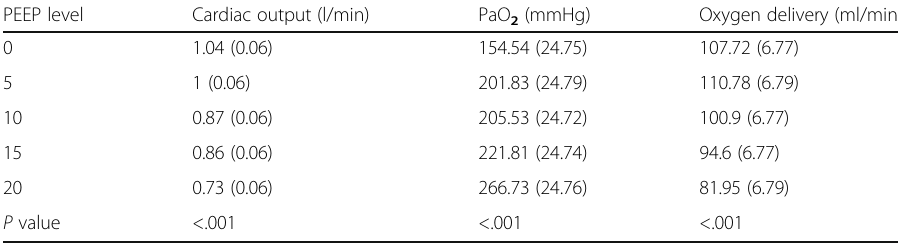
Table 2 Primary outcomes: mean CO, PaO 2 , and oxygen delivery after adjustment for time and baseline values